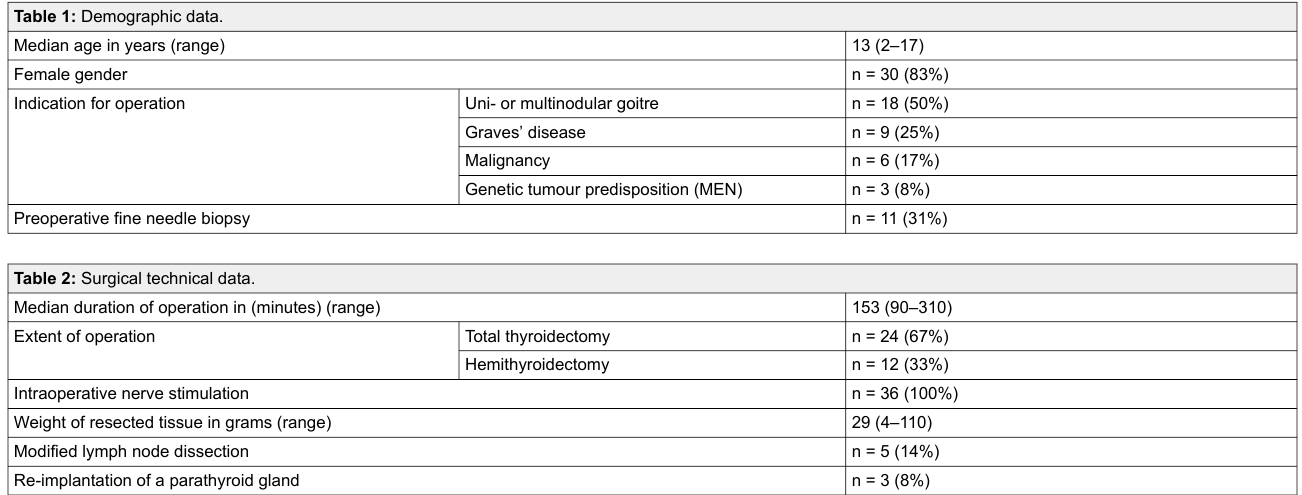
Table 1: Demographic data.